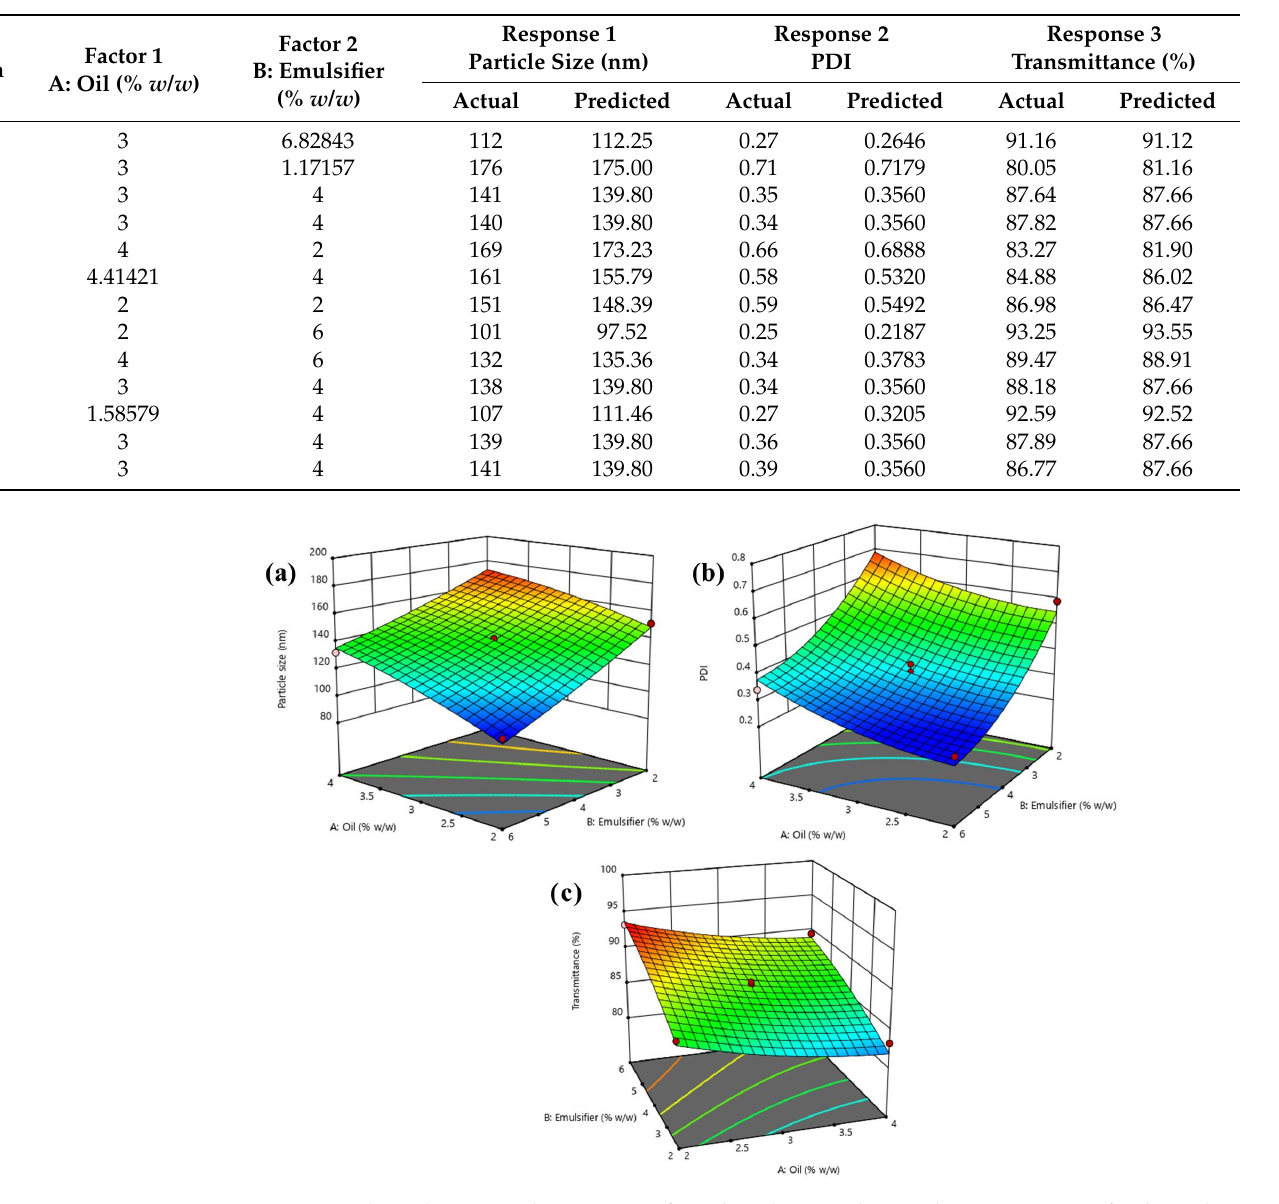
Figure 2. Three-dimensional response surface plots showing the simultaneous impact of independent variables on response parameters: ( a ) particle size, ( b ) PDI and ( c ) percent transmittance of lidocaine-loaded nanoemulsion within CCD experimental design. Table 2. Observed CCD experimental runs on lidocaine-loaded nanoemulsion with their actual and predicted experimental value of particle size, PDI and transmittance.